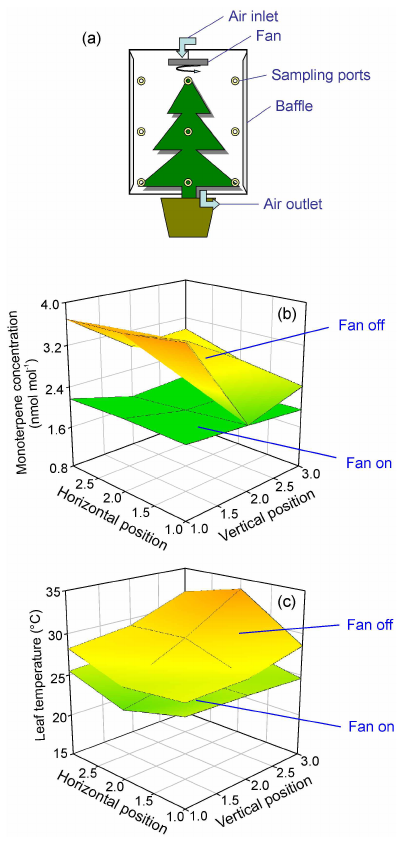
Fig. 2. Illustration of a whole plant BVOC measurement cham- ber for estimation of the distribution of BVOC concentrations and leaf temperatures throughout the chamber (a) , and BVOC concen- tration (b) and leaf temperature (c) gradients with and without the mixing fan on. The vertically orientated blades of the fan and the baffles of the chamber frame optimize turbulent air mixing, thus generating a homogenous atmosphere at relatively low wind speeds (Staudt et al., 2000 for a more detailed description of the chamber system). A young Norway spruce ( Picea abies ) tree was enclosed in the chamber, and BVOC concentrations (b) and needle tempera- tures (c) were simultaneously measured at nine different positions inside the chamber either with the mixing fan off (upper plots) or with the fan on (lower plots). The chamber was located in cool air-conditioned greenhouse. BVOC concentrations and leaf tem- peratures are much more homogenous with the fan running than when the fan is stopped. Furthermore, when the fan is switched off, leaf and air temperatures inside the chamber increase due to de- creased heat exchange between the chamber and the cool air outside the chamber in the air-conditioned greenhouse, and consequently BVOC emissions and concentrations increase. When the fan is off, highest BVOC concentrations occur in the lower part of the cham- ber, while the highest temperatures are in the upper part, reflecting the strongly asymmetric biomass distribution in the spruce trees as well as lack of mixing of chamber air. The measurement positions are defined for the horizontal as: 3 – west, 2 – middle, 1 – east; and for the vertical: 3 – top, 2 – middle and 1 – bottom (based on the data of Staudt,